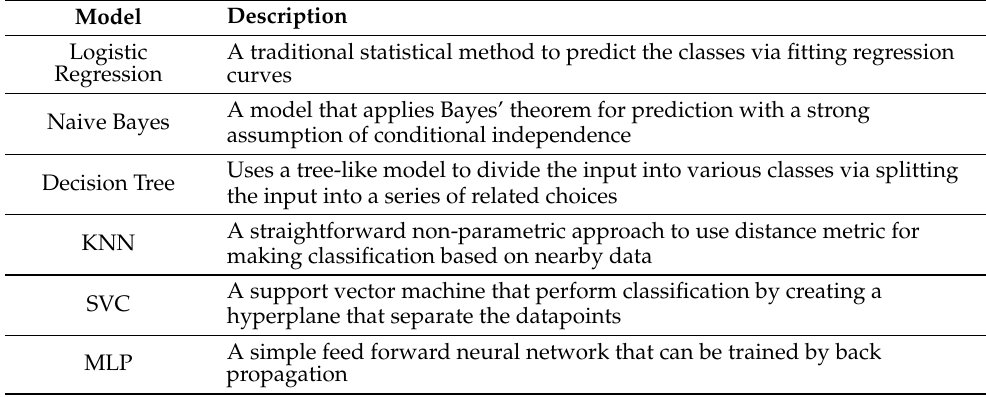
Table 1. Brief description of each machine learning